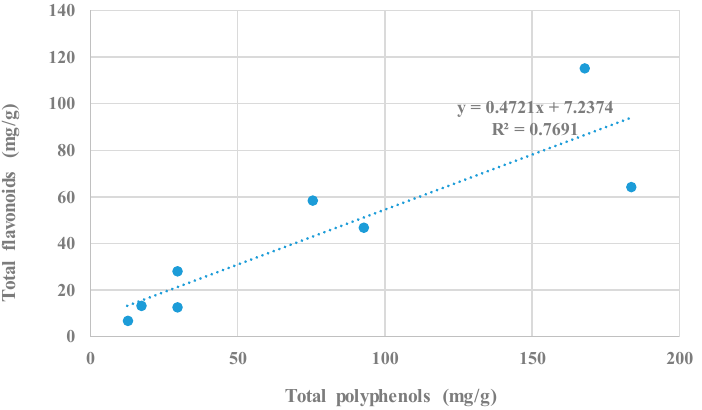
Figure 5. Correlation between total polyphenol and total flavonoid content of alcoholic liqueurs